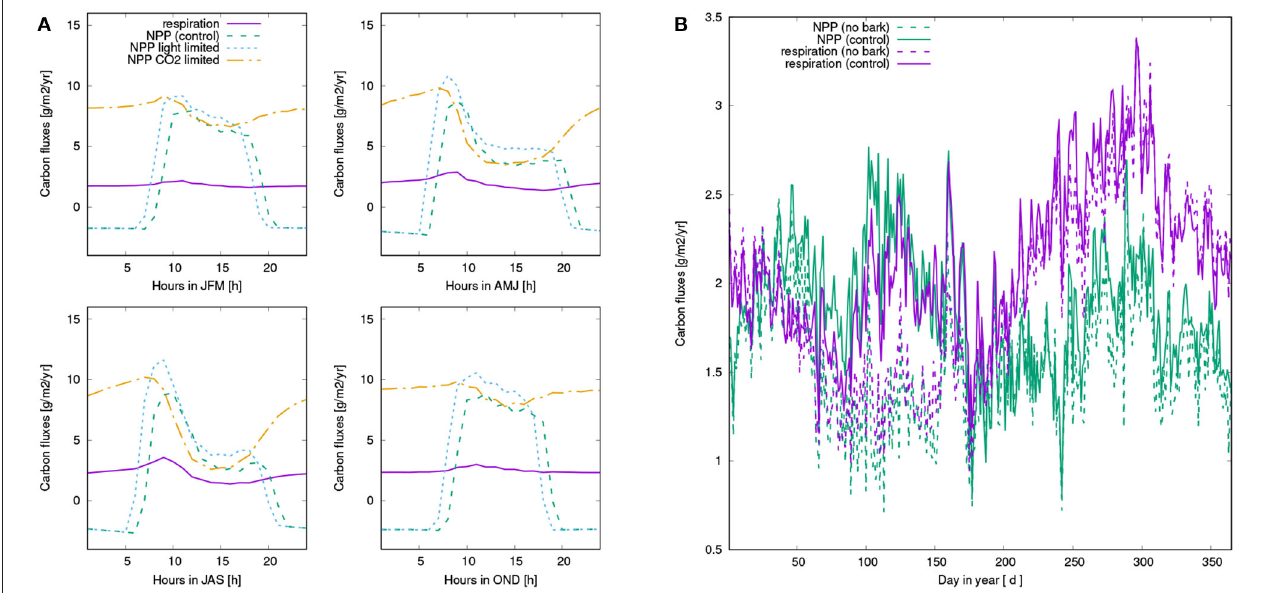
FIGURE 7 | (A) Mean diurnal pattern of simulated carbon fluxes for four seasons, averaged over all surviving strategies of the control run: Net photosynthesis (green), Respiration (purple), light-limited rate of net photosynthesis (blue), and CO 2 -limited rate (orange). Net photosynthesis is computed as the minimum of the two rates. (B) Seasonal pattern of carbon balance of NV epiphytes: NPP (green) and respiration (purple) of the control run (solid lines) and the run without bark water uptake (dashed lines). All values are based on averaging over the last 10 years of the simulation.